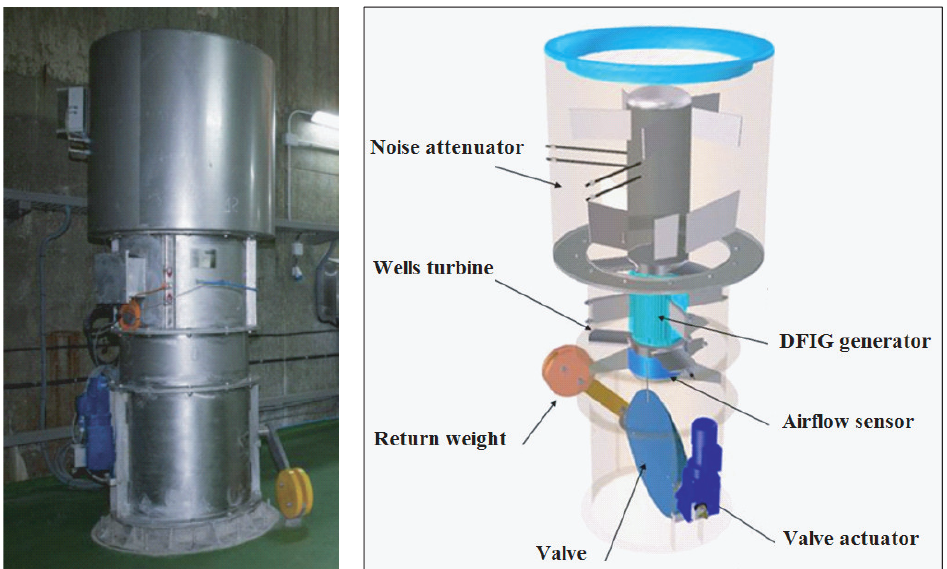
Figure 2. PTO of an oscillating water column (OWC) combining Wells turbine and doubly fed induction generator (DFIG).